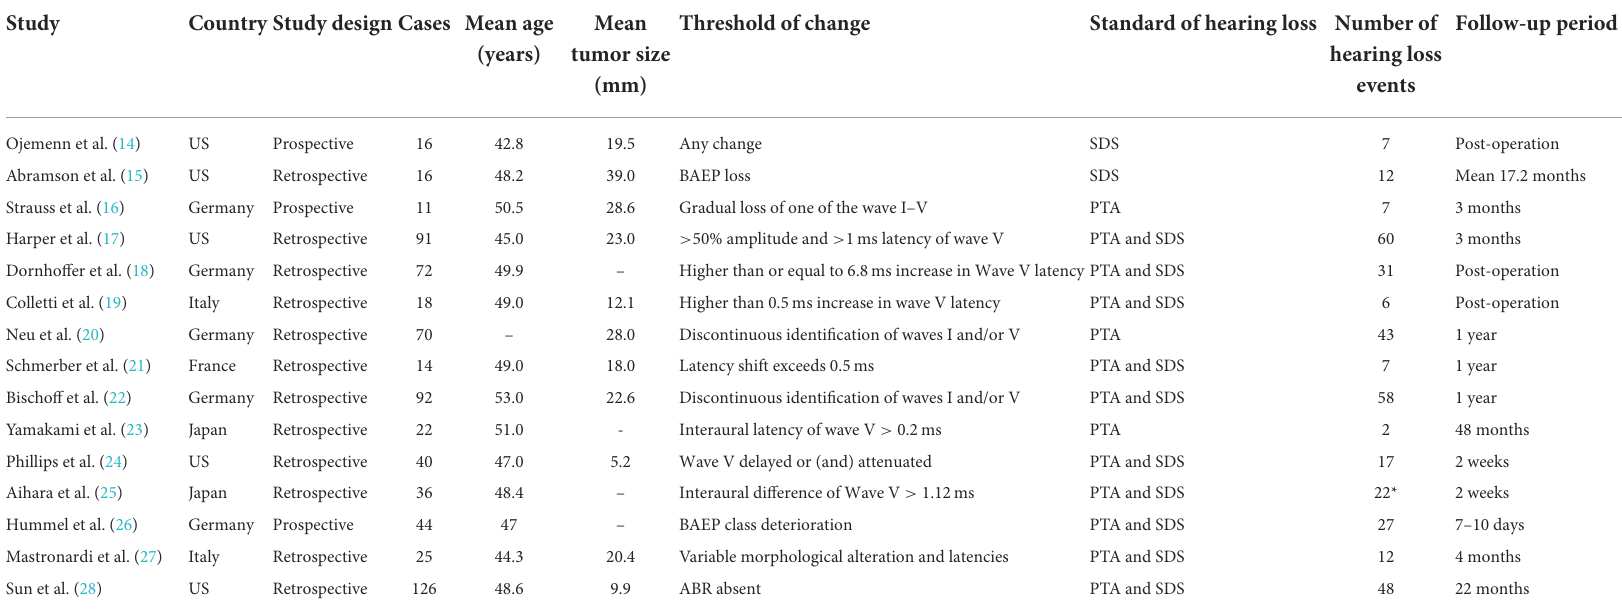
TABLE 1 Baseline characteristics of included